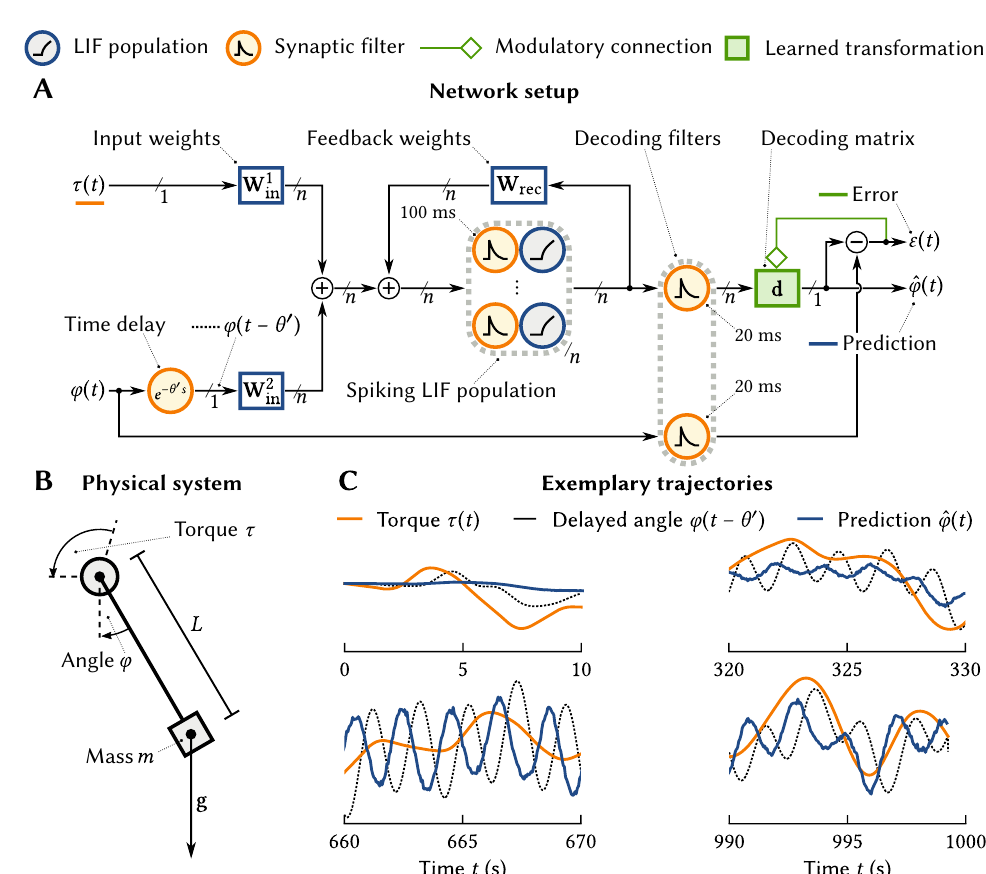
Figure 6. Using neurons with time cell tuning to predict nonlinear pendulum dynamics. ( A , B ) Overview of the experimental setup. The torque τ ( t ) and a delayed angle ϕ ( t − θ (cid:48) ) are fed into a recurrent neural network with time-cell tuning over two dimensions. We use the delta learning rule to learn connection weights online that recombine the neural activities to predict the angle in θ (cid:48) seconds. ( C ) The system learns to predict the pendulum angle with a normalized RMSE of about